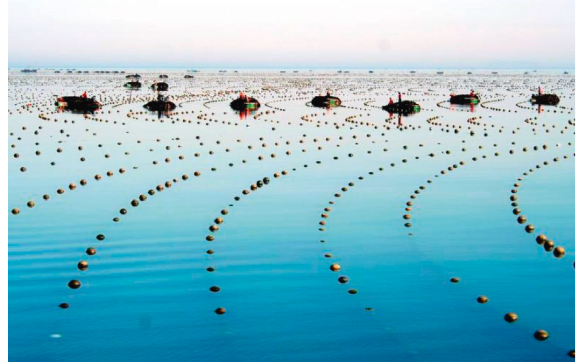
Figure 2: Marine fisheries culture